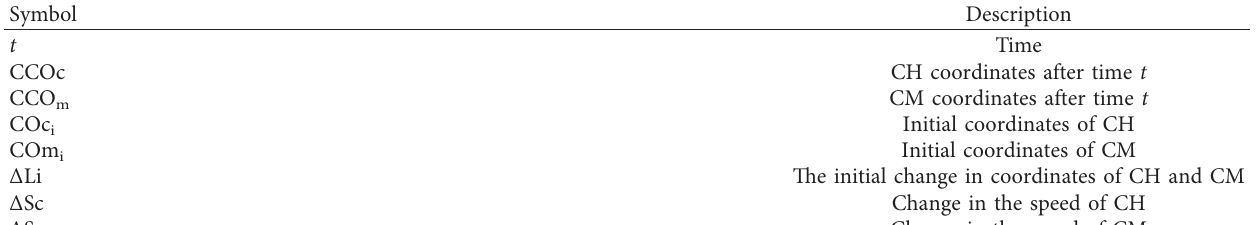
Table 1: Symbol definitions.